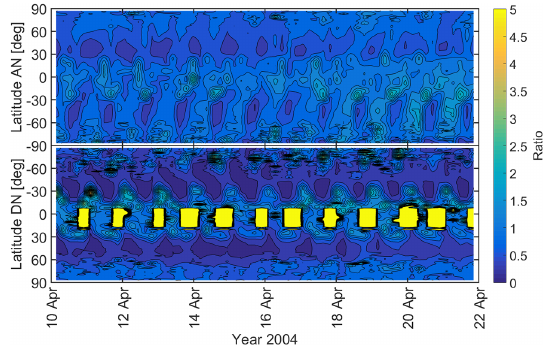
Figure 21. Electron density ratio (GITM / CHAMP) as a function of time and latitude for “case f” (LTAN = 1:06, LTDN = 13:06). agrees well (1 : 1 ratio) with the flight measurement only for F10.7 values between 150 and 170 W m − 2 Hz − 1 (i.e.